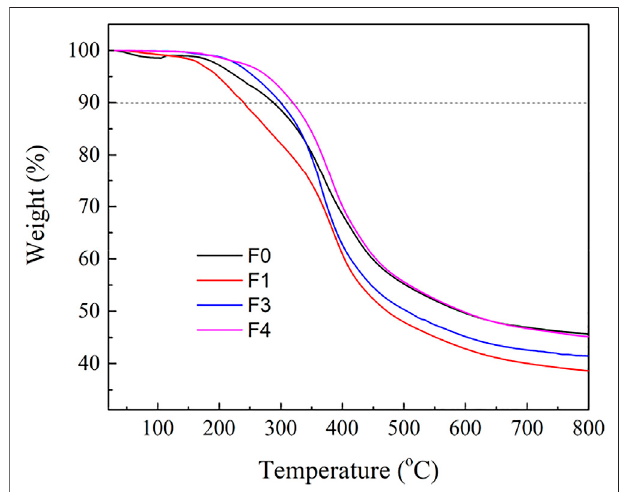
FIGURE 5 | TG curves of tobacco stalk lignin and fractionated